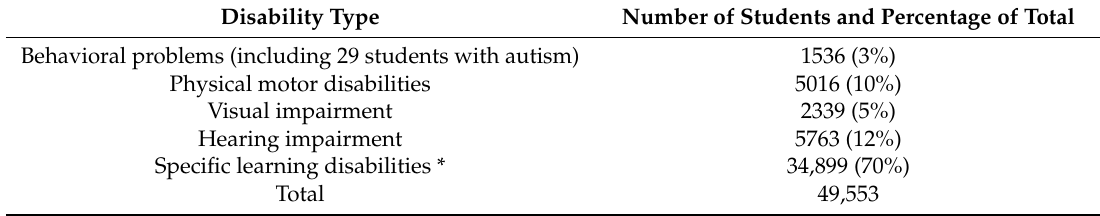
Table 1. Number and percentage of students with special needs in inclusive education in 2014–2015 academic